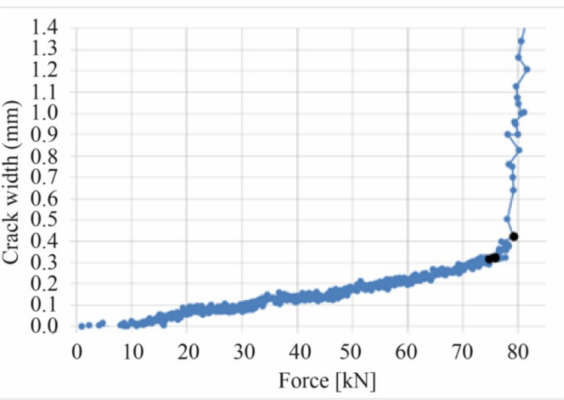
Figure 30. Increase in the width of crack no. 11 on beam C2M-2 during